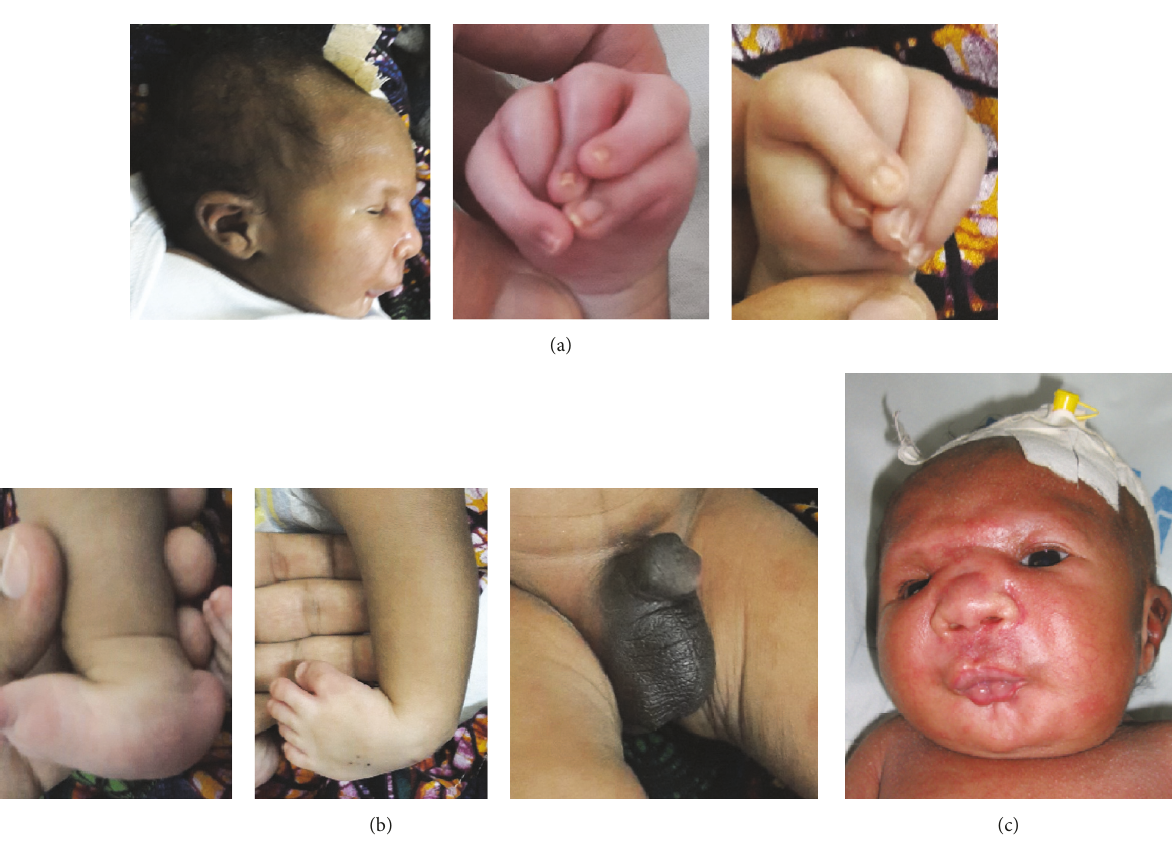
Figure 1: (a) from left to right shows micrognathia and low-set crumpled ears, camptodactyly of the right hand, and camptodactyly and “windmill vane position” of the left hand. (b) from left to right shows congenital vertical talus of the right foot (rocker bottom foot), Talipes equinovarus of the left foot (club foot) and chordee. (c) shows the “mask-like” face with a wide and flat nasal bridge, ocular hypertelorism, microstomia, and puckered lips (“whistling